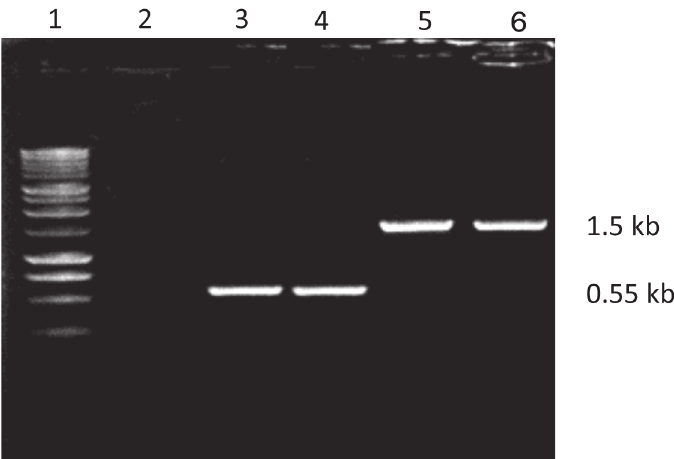
Figure 2. Speci fi c PCR of total DNA from D and ND Verticillium dahliae isolates using the D and ND-speci fi c prim- ers. Lane 1, 1 kb DNA ladder (Promega); 2, negative control; 3, V138I; 4, D. V. dahliae isolate V V. dahliae isolate VZa1